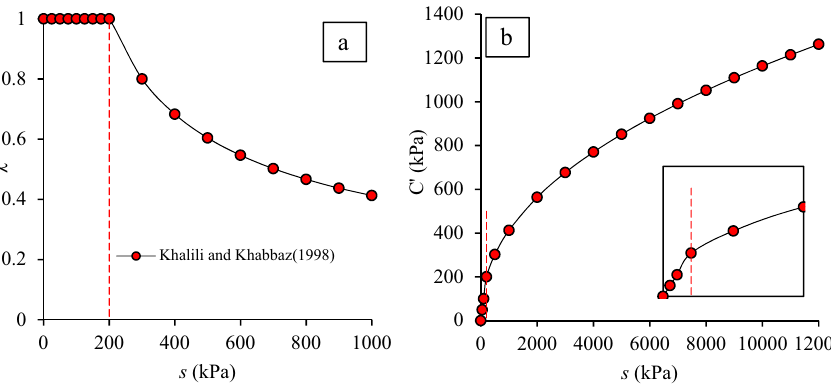
Fig. 1 a Weighting parameter (χ) versus suction and b apparent cohesion versus